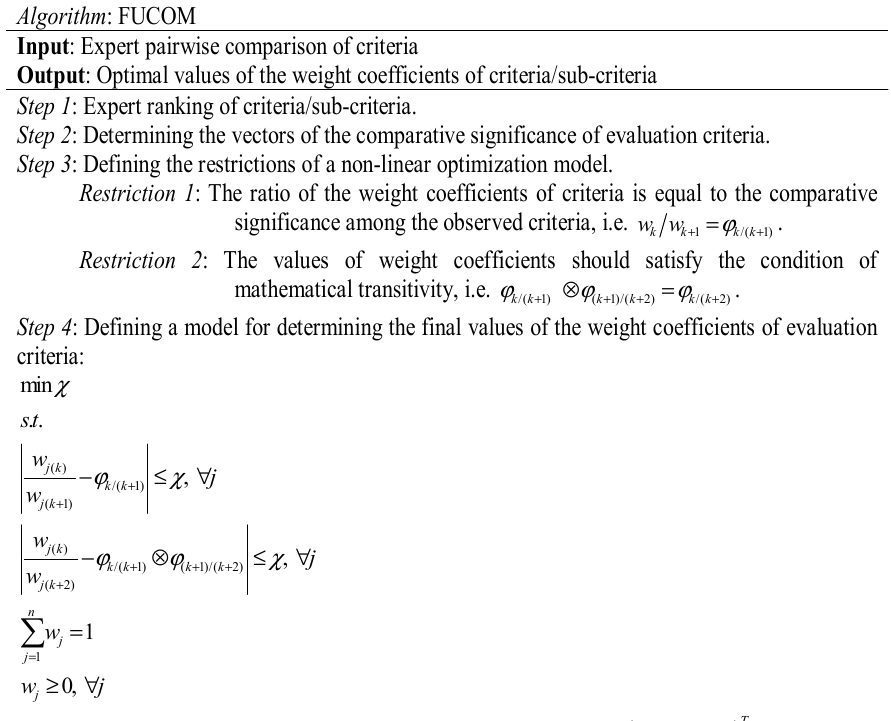
Figure 1. FUCOM methodology [18].